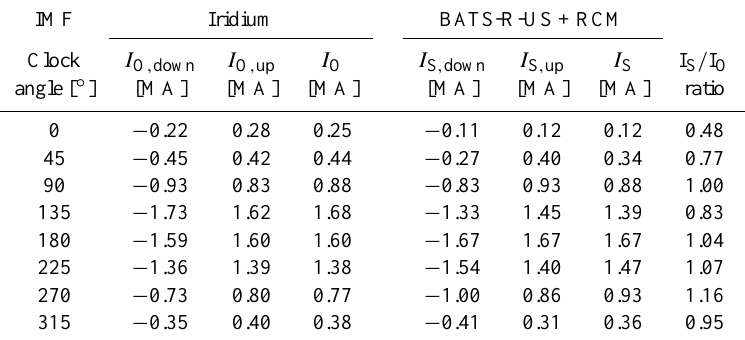
Table 2. Dependence of the Birkeland total current I on IMF clock angle computed from the observed (index “O”) and simulated (index “S”) Birkeland current distributions. The average total currents, I O and I S , represent the averages of the magnitudes of the respective total downward (index “down”) and total upward (index “up”) currents. IMF Iridium BATS-R-US +